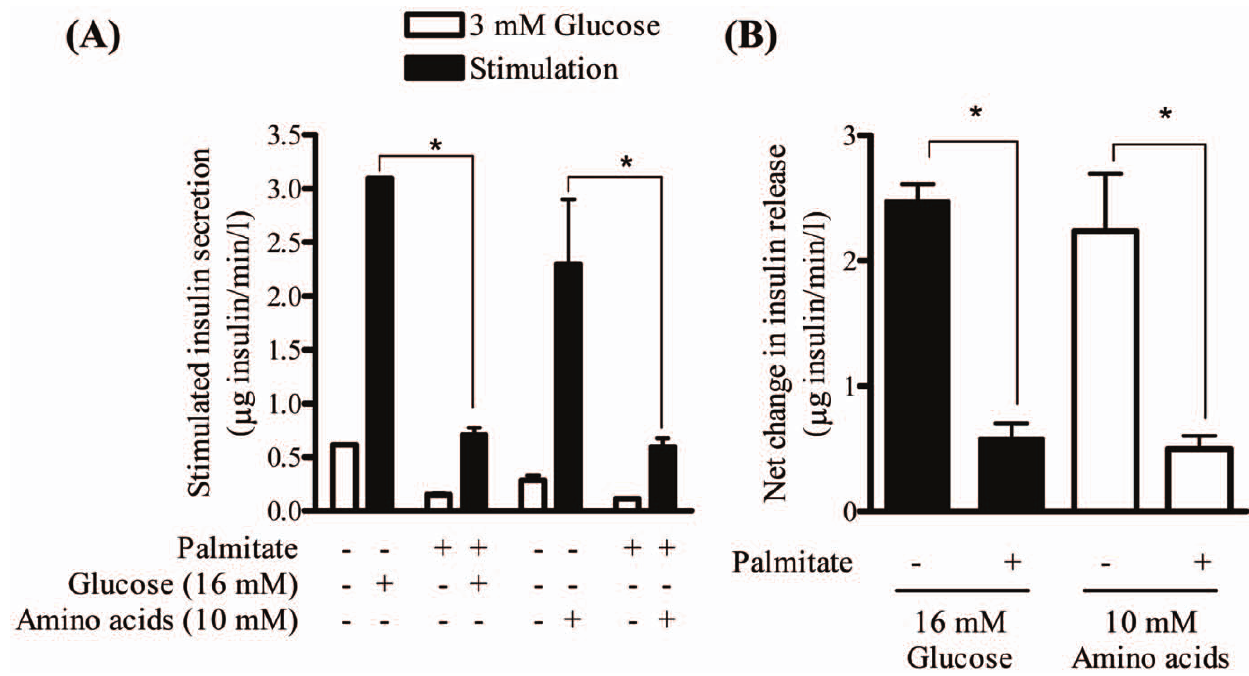
Figure 1. Palmitate induces a loss in glucose- and amino acid-stimulated insulin secretion. (A) MIN6 b cells were incubated with palmitate (0.4 mM) for 48 h prior to incubation with glucose (3 mM or 16 mM) or with an amino acid/glucose mix (10 mM leucine and glutamine/3 mM glucose) for 1 h. Glucose-stimulated insulin secretion (GSIS) and amino acid-stimulated insulin secretion (AASIS) were then assessed as described in the methods. The net change in insulin secretion from 3 to 16 mM glucose or to 10 mM amino acid was analysed and graphed (B). Values are mean 6 SEM from 3 separate experiments. The asterisk signifies a significant difference from the appropriate control (P , 0.05).